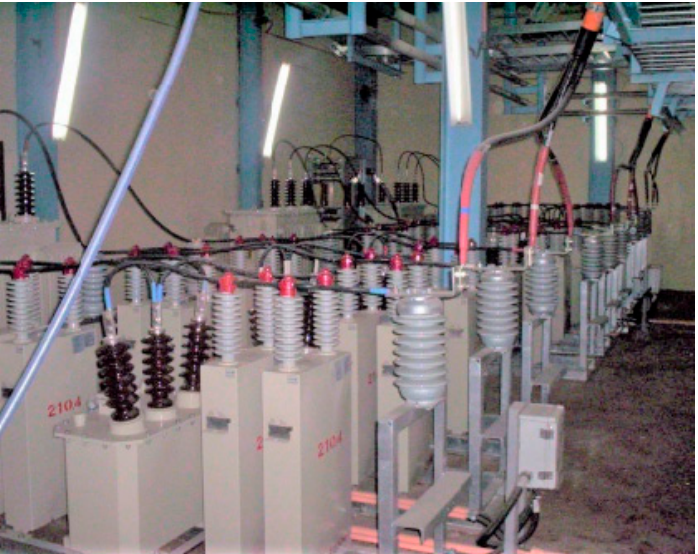
Figure 5. A part of harmonic filter banks.